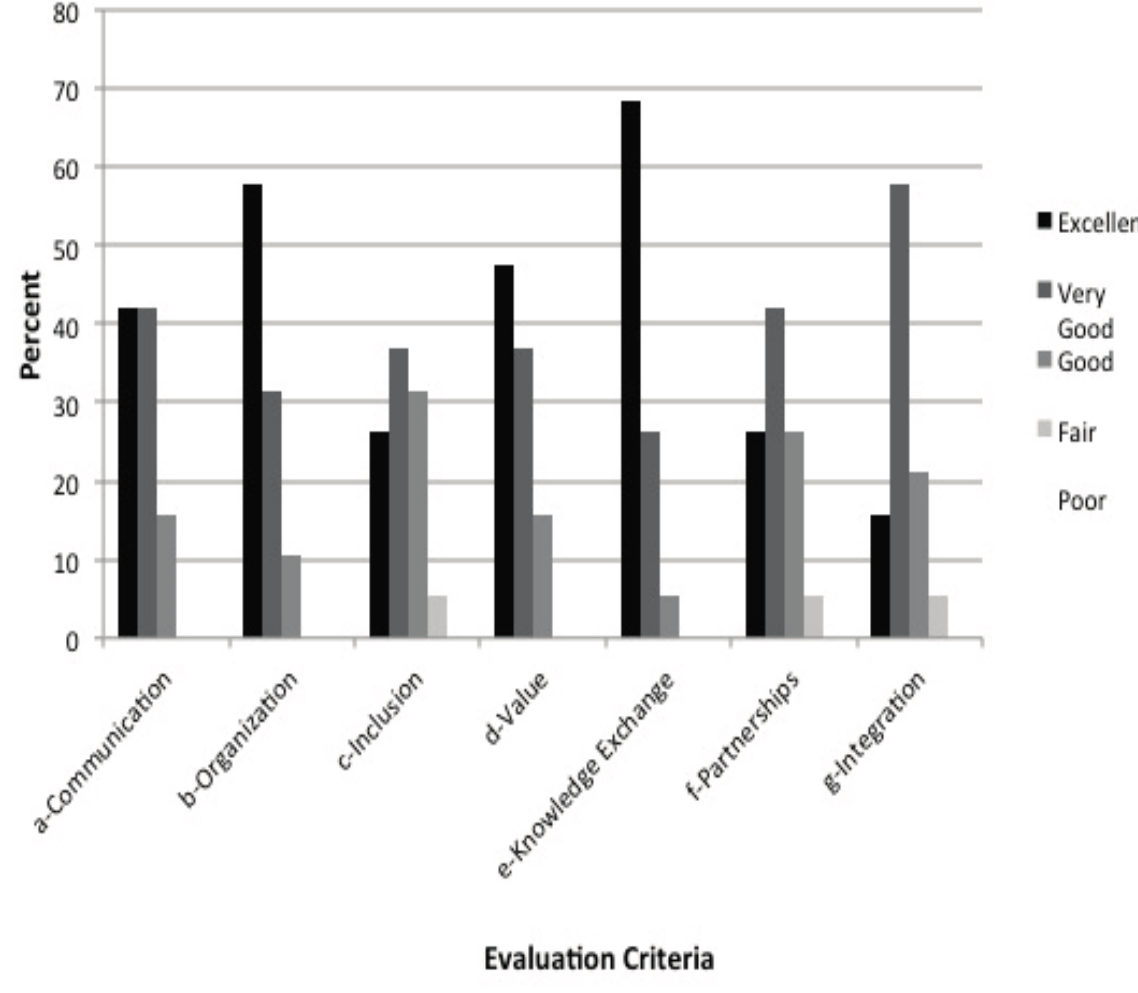
Figure 3. Participant evaluation scores from the third meeting. Scores are representative